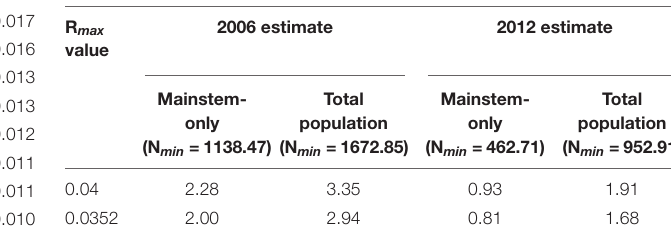
TABLE 3 | Annual PBR values calculated for 2006 and 2012 porpoise population